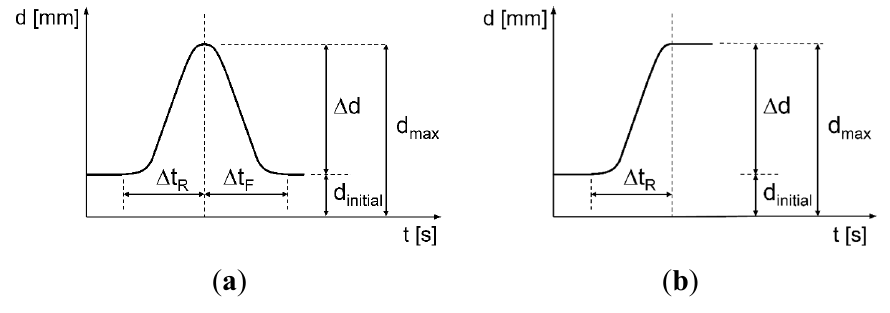
Figure 1. ( a ) Symmetric hydrograph; ( b ) One sided